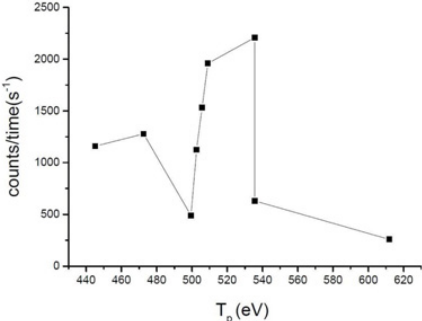
Figure 11. Proton source line profile at 5 · 10 − 3 mbar source H 2